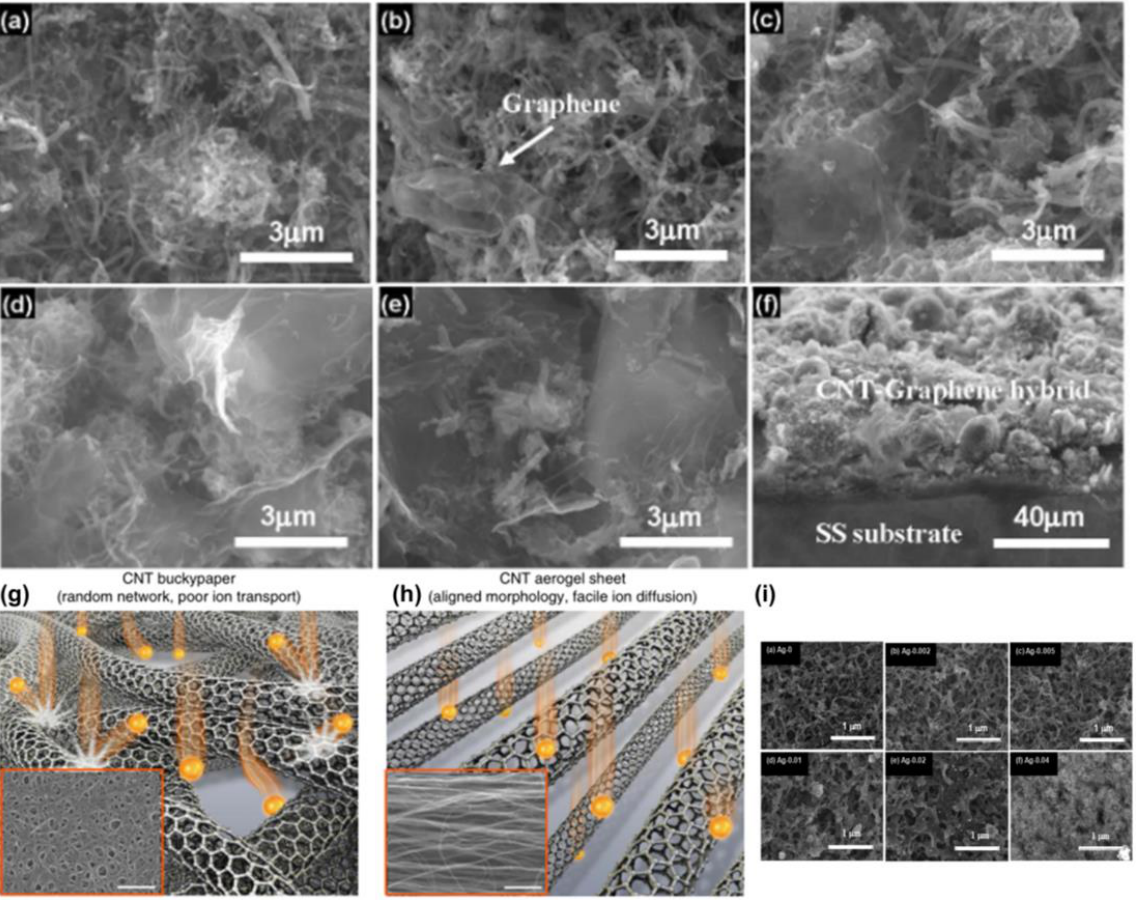
Figure 6. SEM images of the pristine CNTs and CNT–Graphene hybrids. ( a ) The pristine CNTs. ( b – e ) The hybrids obtained by adding 0.04, 0.1, 0.2, and 0.4 g · L − 1 graphenes in the suspension, respectively. ( f ) Cross-section of the CNT–Graphene hybrid. Note: The concentrations of CNTs and Mg 2+ were kept certain values of 0.1 and 0.03 g · L − 1 , respectively. Carbon nanotube aerogel sheets as high-performance electrodes. (Reproduced with permission from [103]. Copyright 2019 MDPI). ( g , h ) Illustrations and SEM micrographs (insets) comparing CNT buckypaper and CNT aerogel electrodes and the relationship of these morphologies to ion transport (scale bars in the insets, 1 mm). MWNT bundling is not shown and only MWNT outer walls are pictured (Reproduced with permission from [104]. Copyright 2016 Springer Nature.). ( i ) SEM images of pristine CNTs and the Ag–MgO–CNTs formed with different concentrations of Ag powder. Pristine CNTs, samples obtained by doping 0.002, 0.005, 0.01, 0.02, and 0.04 g L − 1 of Ag in the suspension, respectively. Note: the concentration of CNTs and Mg 2+ were kept constant at 0.1 and 0.03 g L − 1 , respectively (Reproduced with permission from [105]. Copyright 2011 Royal Society of Chemistry).